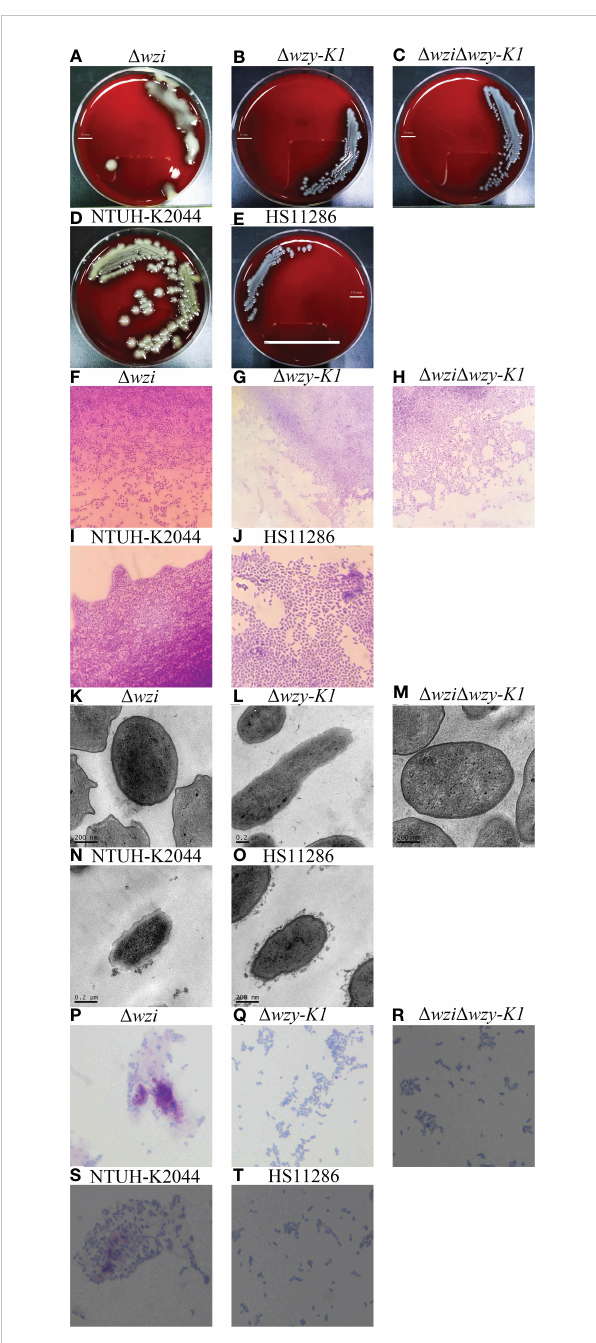
FIGURE 2 Morphological effects of deletions of wzi , wzy-K1 , and wzi+wzy-K1 on Klebsiella pneumoniae . (A – E) Colonies of D wzi , D wzy-K1 , D wzi D wzy- K1 , NTUH-K2044, and HS11286; (F – J) Capsule staining of D wzi , D wzy-K1 , D wzi D wzy-K1 , NTUH-K2044, and HS11286; (K – O) Transmission electron microscopy of D wzi , D wzy-K1 , D wzi D wzy-K1